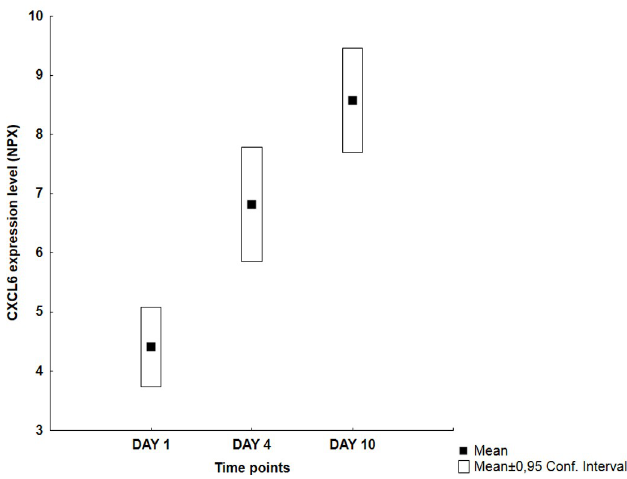
Fig 3. Group C example; CXCL6: Temporal pattern of protein expression level (mean NPX ± 0.95 CI) for C-X-C motif chemokine ligand 6 (CXCL6) showing statistically significant late peak and increasing trend, that is day 1 < day 4 < day 10 mean NPX values (4,41 vs 6,81 vs 8,57 respectively; p < 0,005).